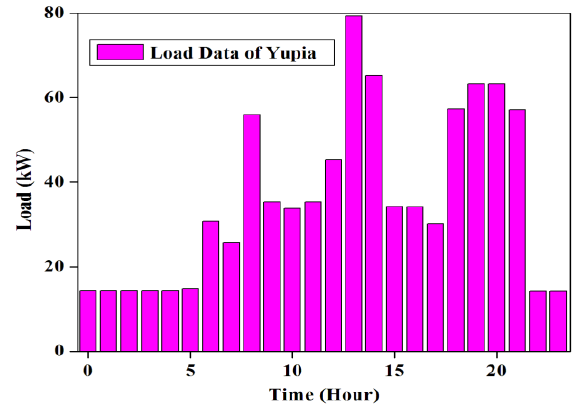
Figure 3. Hourly distribution profile of the load consumption for Yupia.